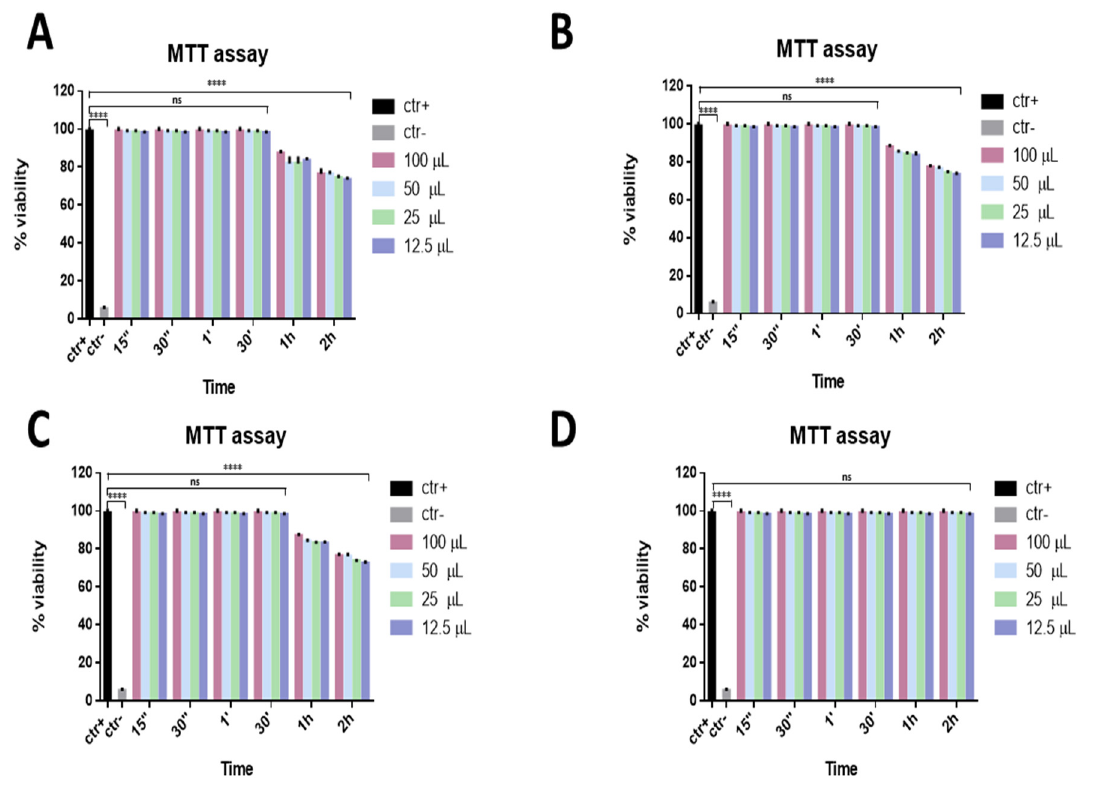
Figure 1. Viability assay. Cytotoxicity was assessed via MTT assay after different stimulation times. Vero cells were exposed to different volumes of Iodim ( A ), Ozodrop ( B ), Dropsept ( C ), and Septavis ( D ) for 15 s, 30 s, 1 min, 30 min, 1 h, and 2 h. **** p < 0.0001; ns: non-significant.